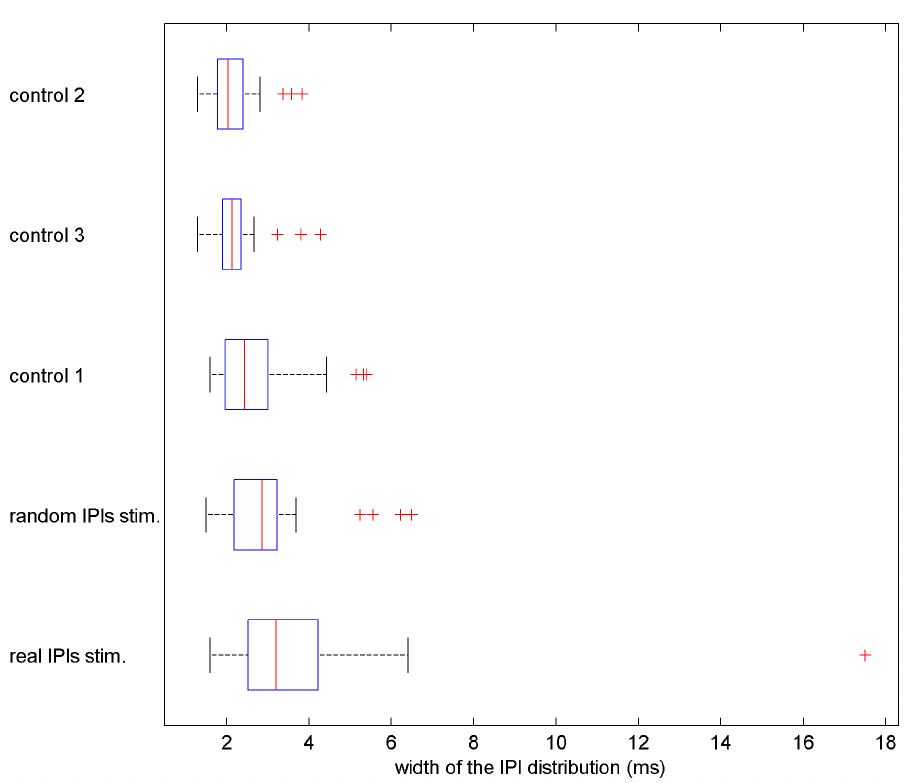
Figure 8. Average width of IPI distributions. Fish discharged greater variety of IPIs (wider distributions) during the stimuli sessions compared to the control sessions, medians were 3.2 ms and 2.86 ms for the real and random IPI sessions and 2.43 ms, 2.13 ms and 2.04 ms for control session 1, 3 and 2 respectively. Between the stimuli sessions, the average width of the IPI distributions for the real IPI sessions were wider (Wilcoxon p , 0.05). For the control sessions (Friedman p , 0.05), post-hoc analyzes revealed that control 1 was statistically different than control sessions 2 and 3. The width of the distribution were calculated as the 2–98 percentile measure in 40 s sliding windows.